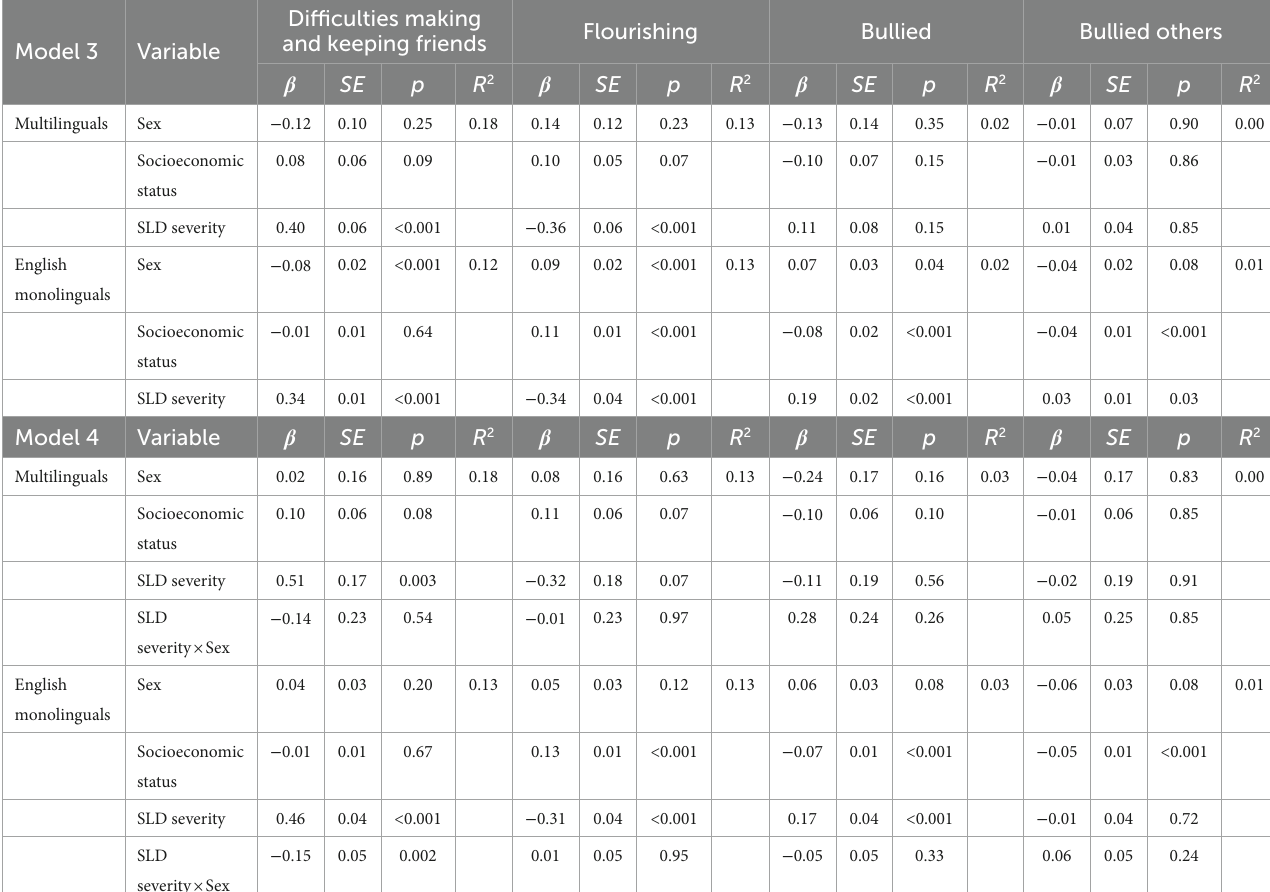
TABLE 7 Regression coefficients of social–emotional functioning by sex, SES, and speech language disorder severity by group. Difficulties making Flourishing Bullied Bullied others and keeping friends Model 3 Variable